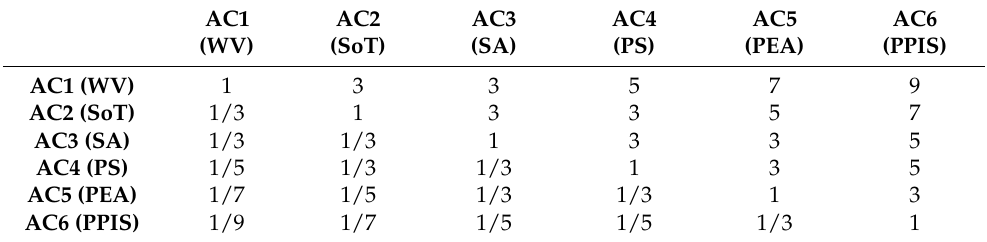
Table 4. Pairwise comparison matrix of the assessment criteria with respect to the goal under Scenario